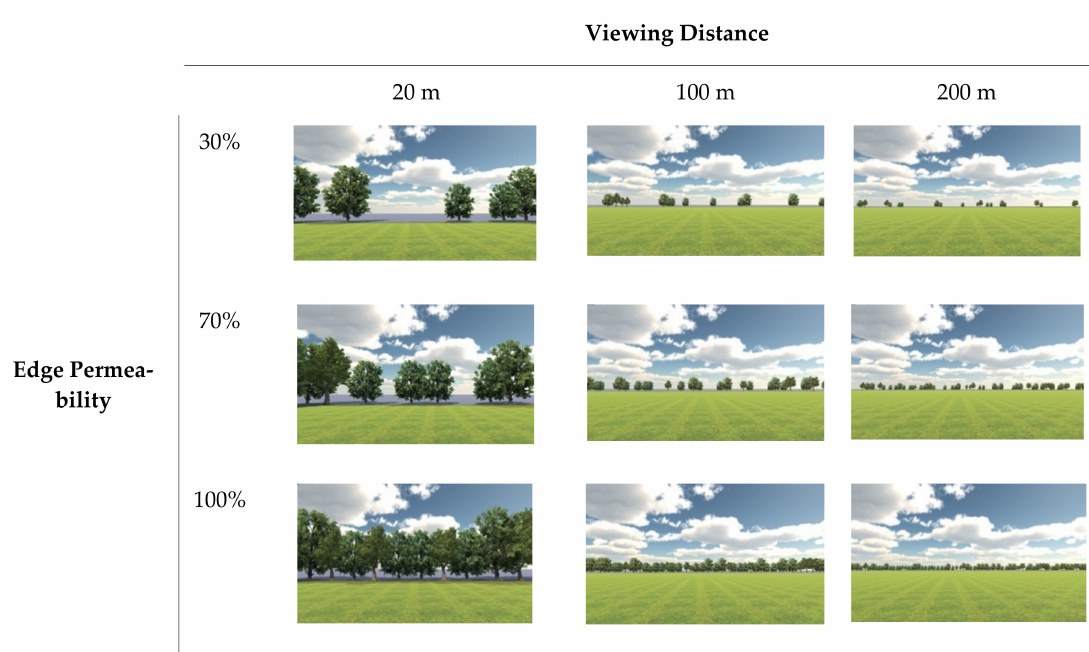
Figure 3. VR landscape scene